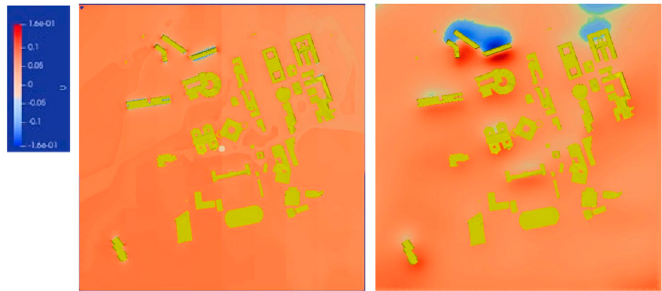
Figure 6. Numerical predictions of the flow field at University of León campus showing the different flow patterns for two different wind directions.